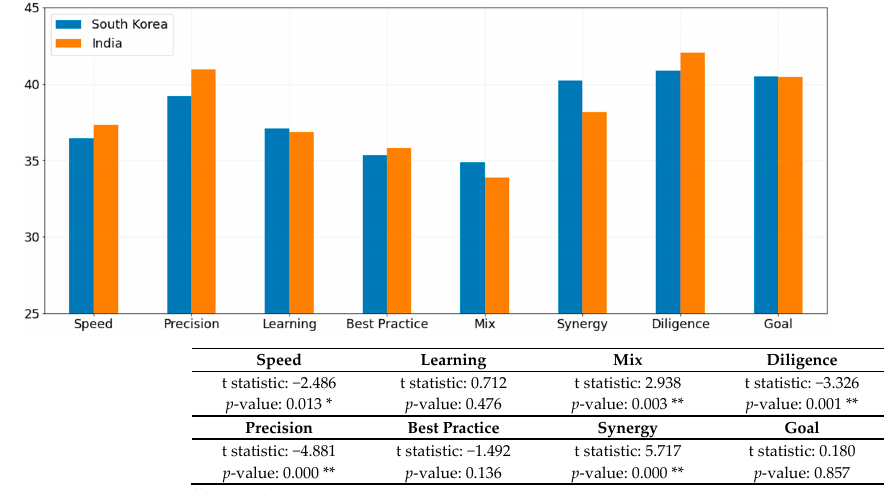
Figure 4. Average similarity scores for eight factors.